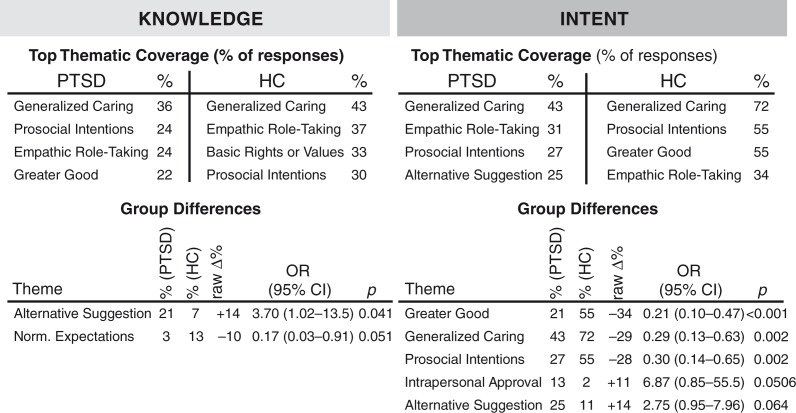
Most common themes and group differences found in personal moral dilemmas.